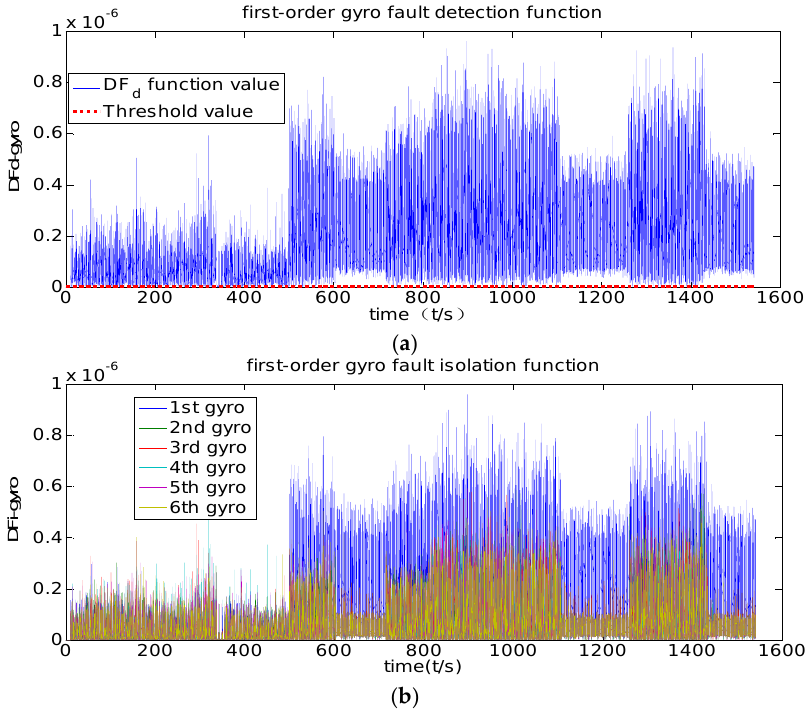
Figure 15. First ‐ order channel filter. ( a ) Fault detection; ( b ) Fault isolation.